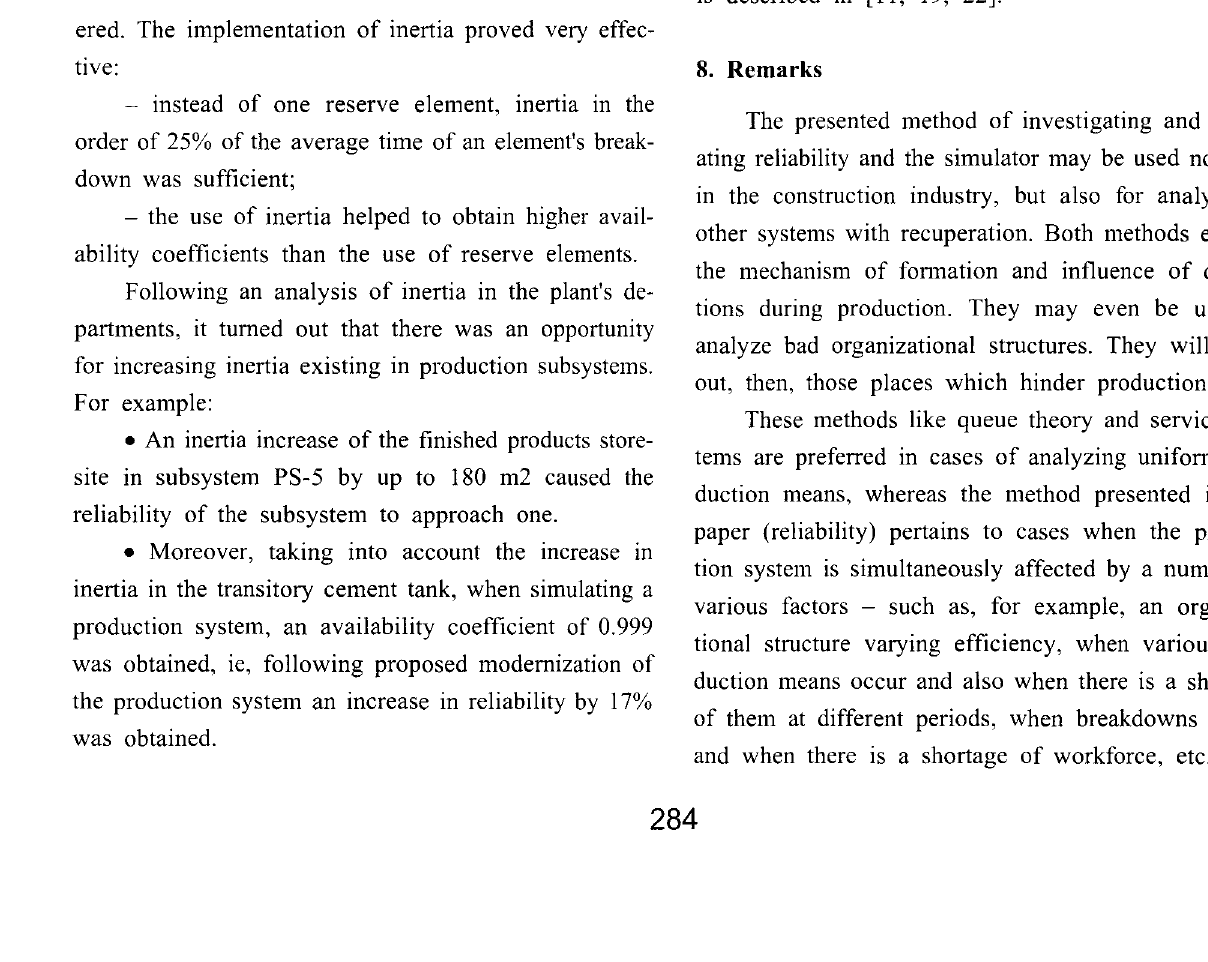
Fig 4. Dependence of the availability coefficient of a 5- phase system on changes of inertia location in the system's